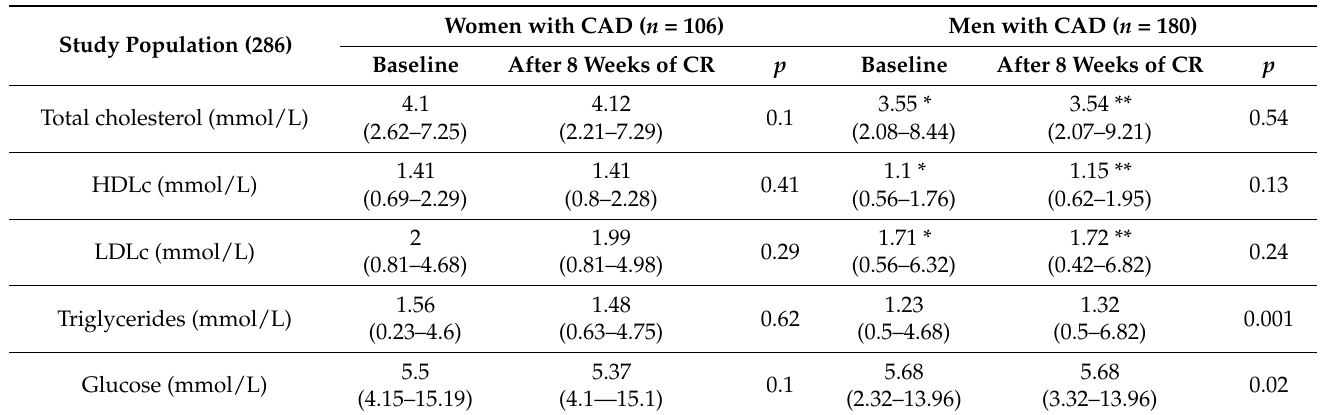
Table 3. The cholesterol and the glucose serum concentration in the examined women and men with CAD at baseline and after 8 weeks of CR